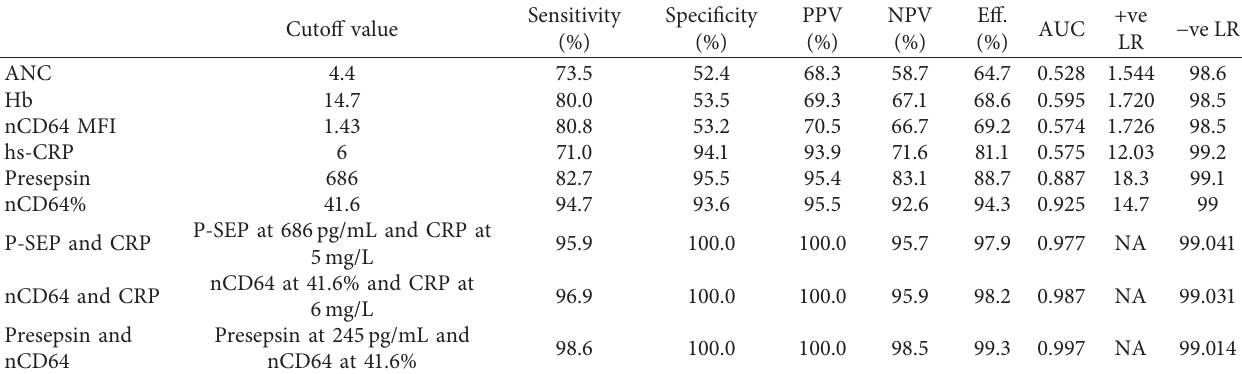
Table 5: Diagnostic performance of the studied parameters and their combinations arranged in the ascending order in terms of their